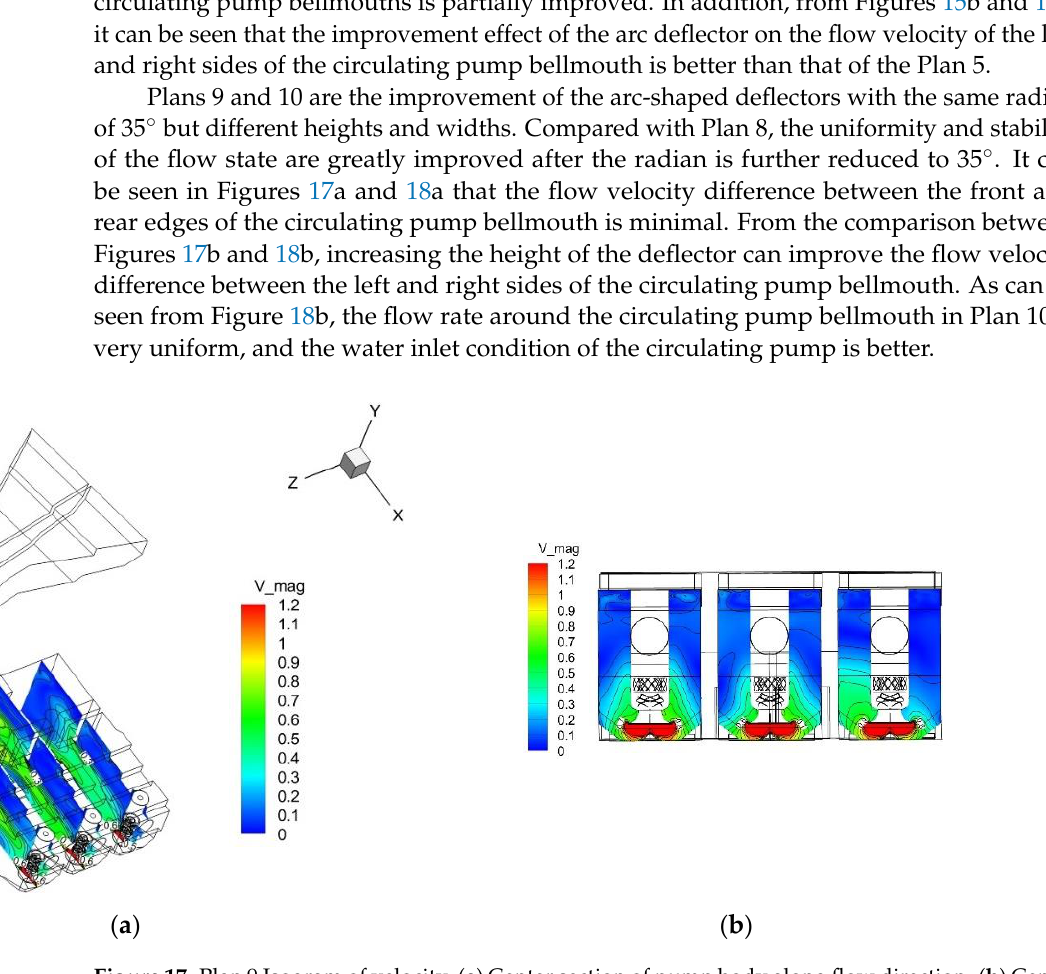
Figure 16. Plan 8 isogram of velocity. ( a ) Center section of pump body along flow direction. ( b ) Center section of pump body in vertical flow direction.